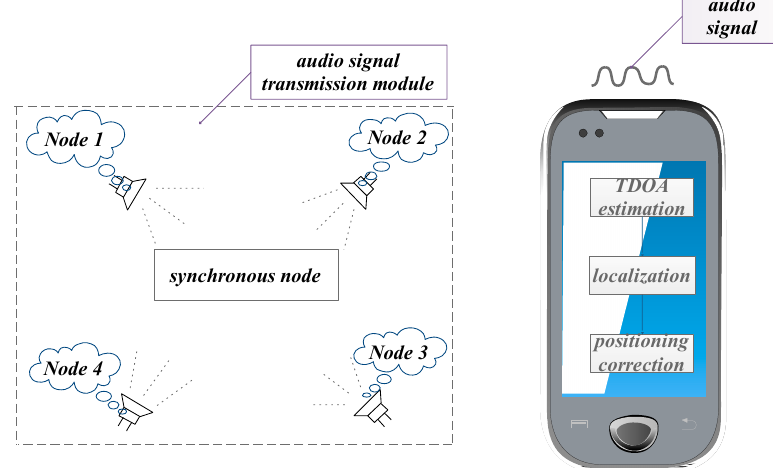
Figure 1. Diagram of the time difference of arrival (TDOA)-chirp-based system.